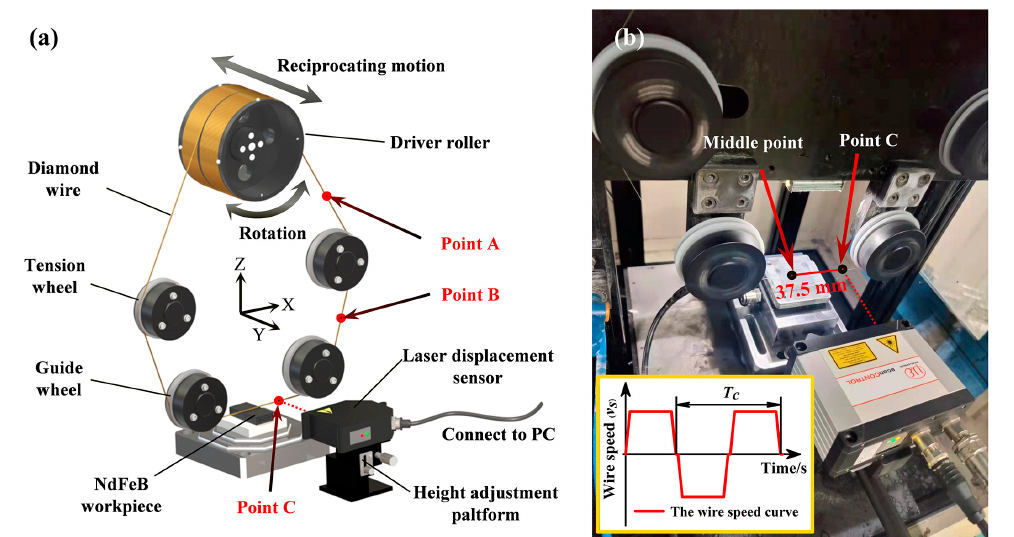
Figure 1. ( a ) Diamond wire sawing experiment setup; ( b ) diamond wire in the sawing area. During the sawing process, the lateral motion of the diamond wire at points A, B, and C was monitored by an ILD2300-50 laser displacement sensor produced by Micro-Epsilon (Beijing) Measurement Co., Ltd. The laser spot diameter of the ILD2300-50 was 70 μ m, which is smaller than the diameter of the diamond wire used in this experiment. The sampling rate of the laser displacement sensor is 10 kHz. By adjusting the height of the micro-positioning platform fixed under the sensor, the laser can be adjusted to the point at the center of the diamond wire. When the energy intensity has only one peak located near the middle position of the map, it is the laser spot is considered to be on the center of the diamond wire. In this experiment, an N35 NdFeB magnet with a size of 25 mm × 10 mm × 50 mm, provided by Advanced Technology & Materials Co., Ltd., Beijing, China, was chosen as a cutting sample. Its composition was provided by the producer, as shown in Table